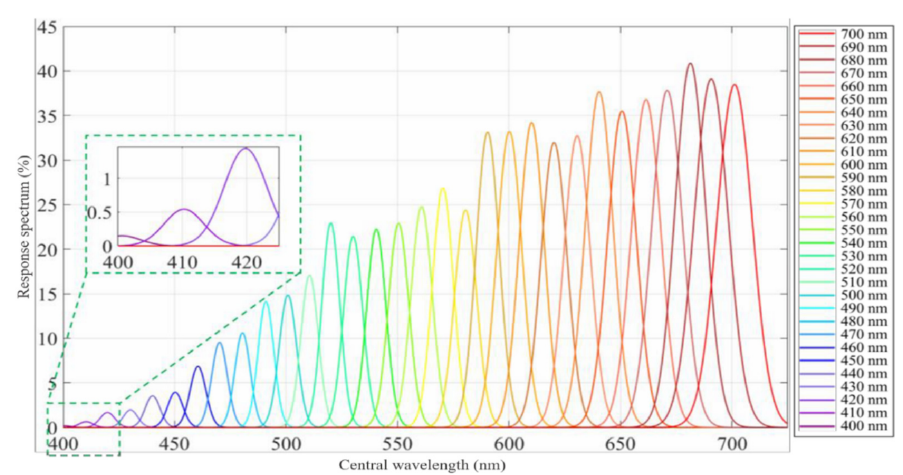
Figure 3. The response spectrum of the designed USI system relative to corresponding wavelengths. The graph represents the system’s capability to distinguish between a full band of 400 nm to 700 nm at a maximum resolution of 10 nm.